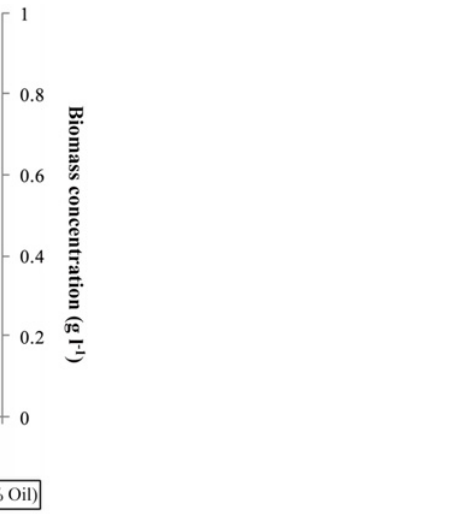
Fig 3. Total residual crude oil waste (bar) and produced biomass concentrations